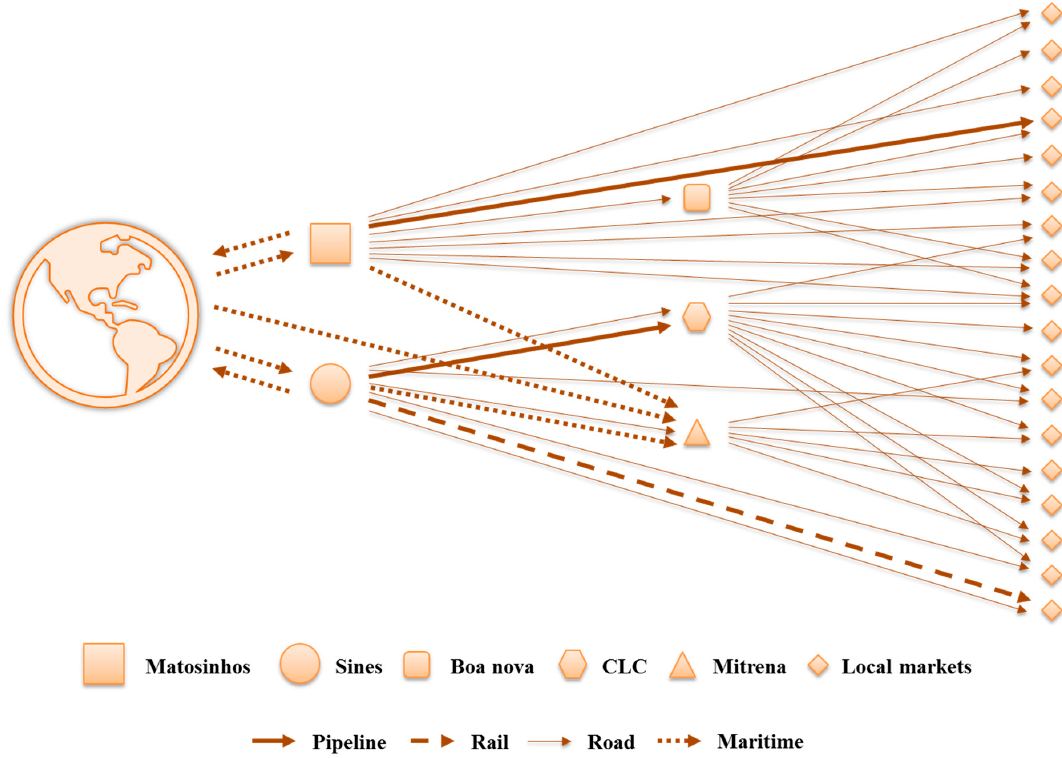
Figure 1. Portuguese downstream oil supply chain (from Lima et al., 2018).